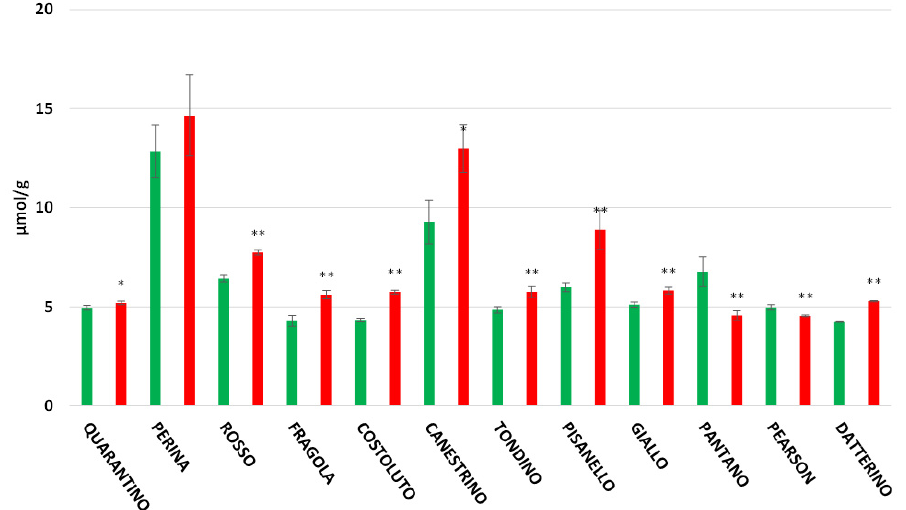
Figure 4. Total antioxidant (expressed as µmol/g of FW) in tomato pulp of 9 Italian cultivars and three commercial cultivars. Controls (CTRL) in green and drought-stressed group (DS) in red. The bars indicate the standard deviation. A significantly difference is shown between CTRL and DS of each cultivar by * for a p ≤ 0.05 and ** for p ≤ 0.01.